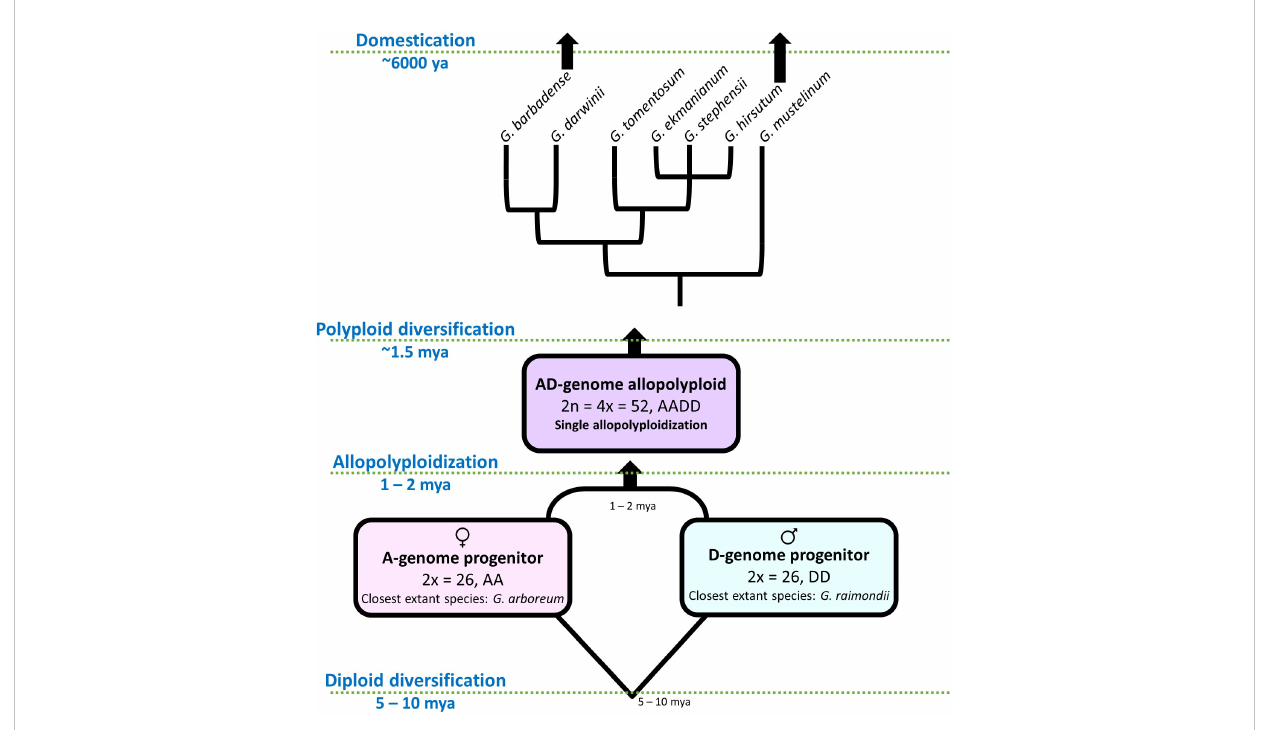
FIGURE 1 Evolutionary model for allopolyploid Gossypium . Approximately 5-10 mya, the cotton underwent diversi fi cation resulting in separate evolutionary trajectories for the now-extinct A-(maternal) and D-(paternal) progenitors of the allopolyploid clade. Subsequently, (~ 1 mya) these lineages hybridized and underwent genome doubling, resulting in the allotetraploid AD clade. This clade diversi fi ed into seven polyploid species, two of which underwent domestication and improvement, i.e., G. hirsutum and G. barbadense